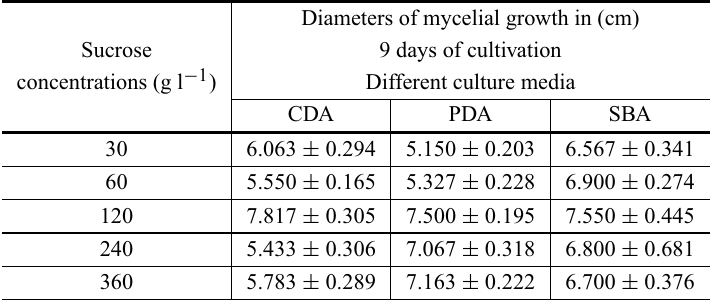
Comparison of mycelial diameter growth of A. flavus in different solid